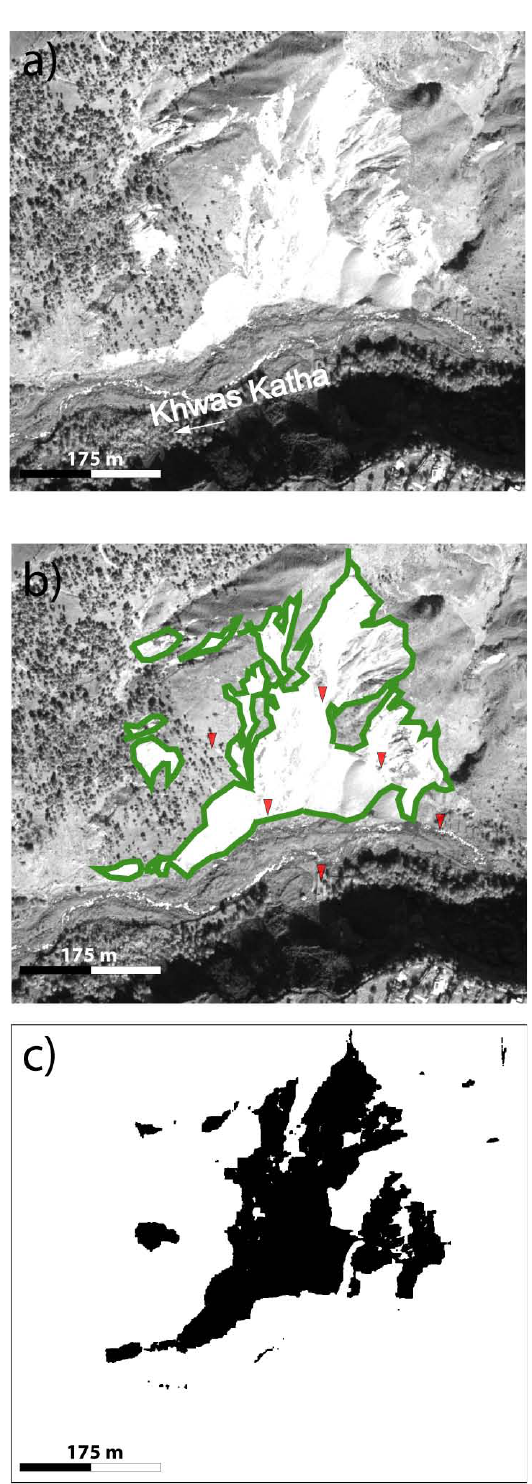
Fig. 8. (a) Pre-event image (11 August 2005) of an area on the south-eastern slope of Balakot (Khwas Katha). (b) Post-event im- age (19 October 2005) of the same area where a large landslide area is contoured by a green line as detected by visual inspection. Red triangles point to a possible deformed area. (c) Landslide (black area) occurring in the area detected by the automatic classification.